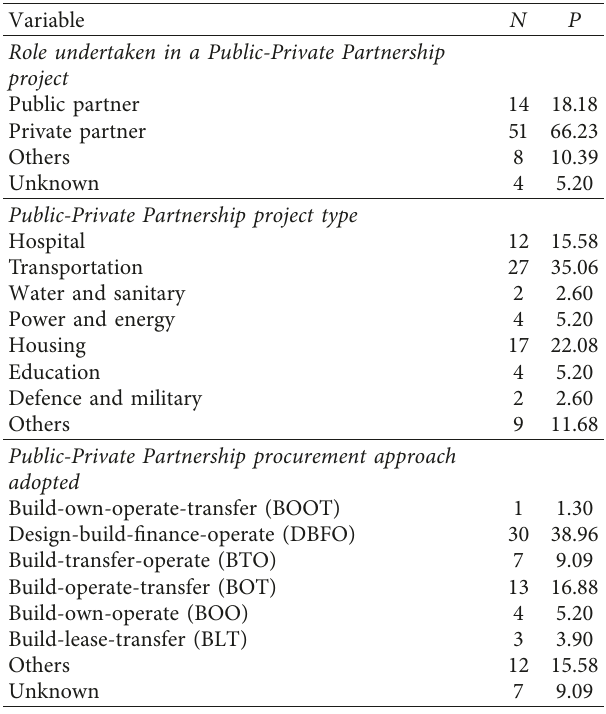
Table 2: Demographic information of the